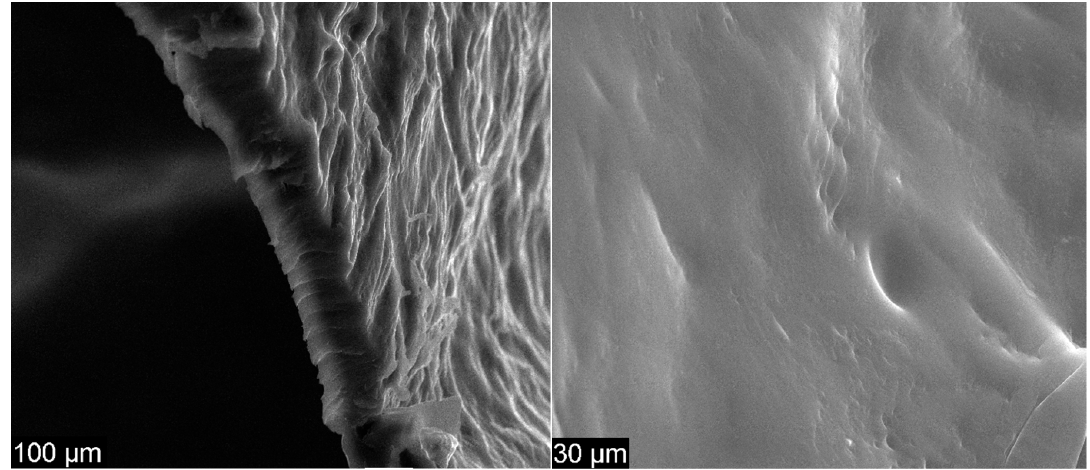
Figure 4. Scanning electron microscopy (SEM) images for GO at 1000 × (left) and 50 k× magnification (right). (right).